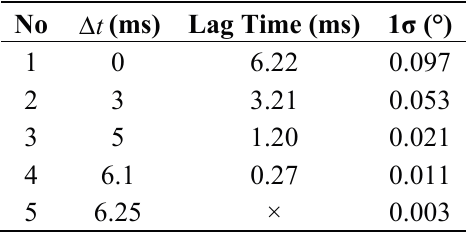
Table 3. Relationship between residual lag time and dynamic attitude errors.